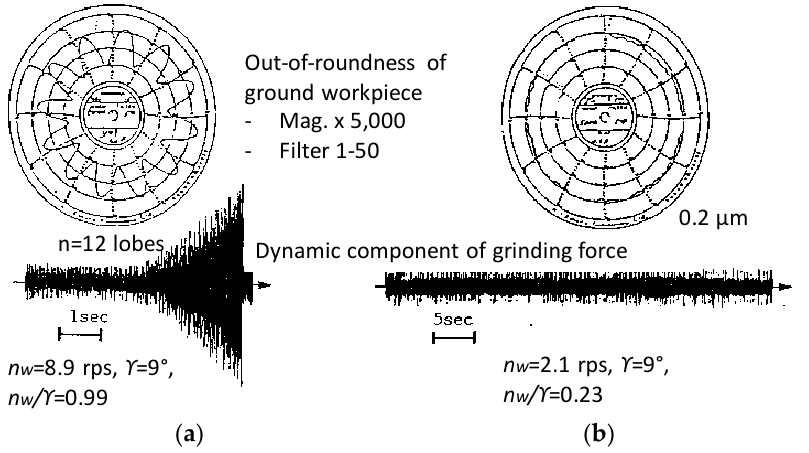
Figure 12. Dynamic stability of centerless grinding system (experiment). ( a ) Unstable grinding process (chatter); ( b ) Stable grinding process.